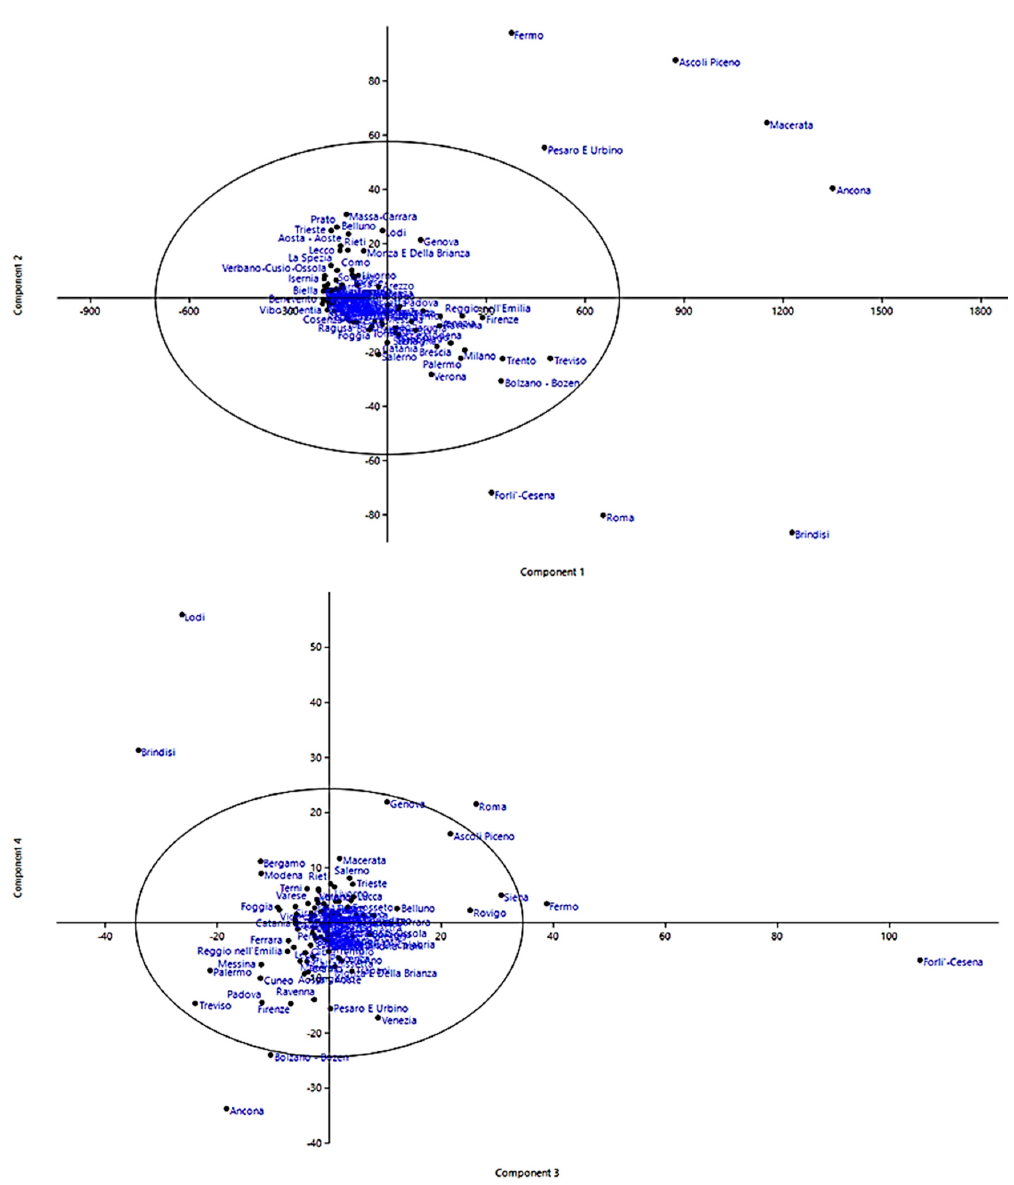
Figure 5. Score plot of principal components ( upper panel : PC 1 vs. 2; lower panel : PC 3 vs. 4).